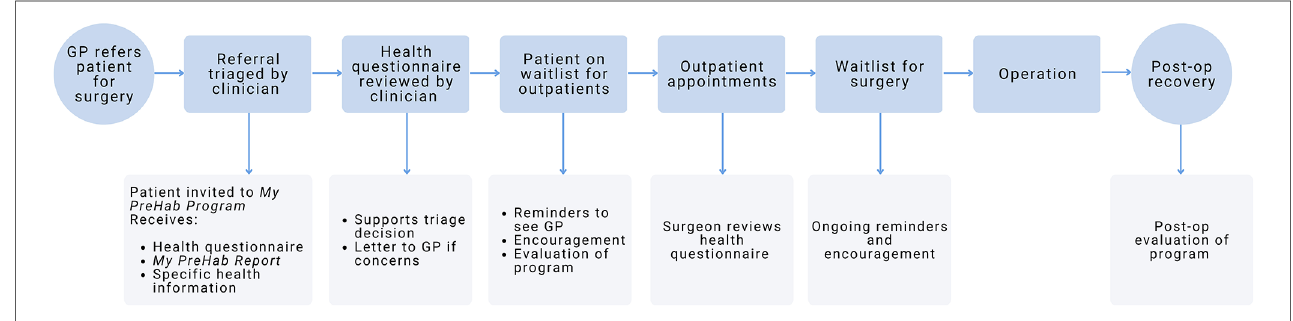
FIGURE 4 My PreHab Pathway